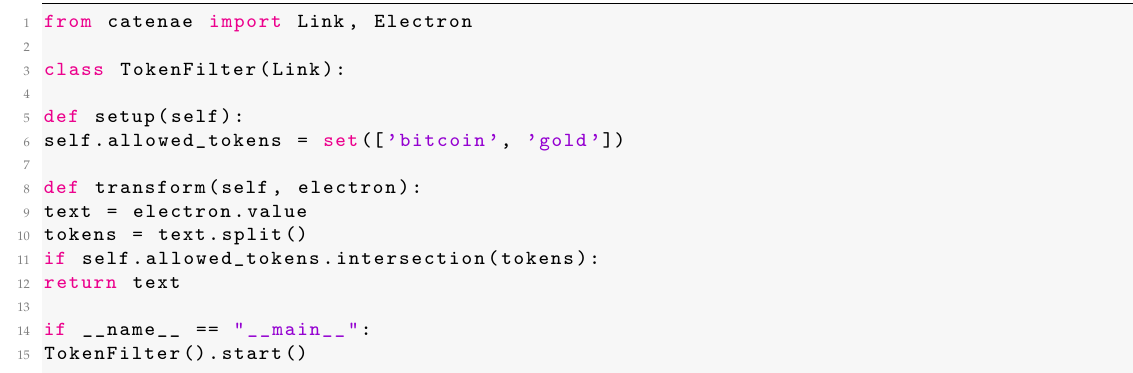
Figure 2. Implementation of a middle microservice (token